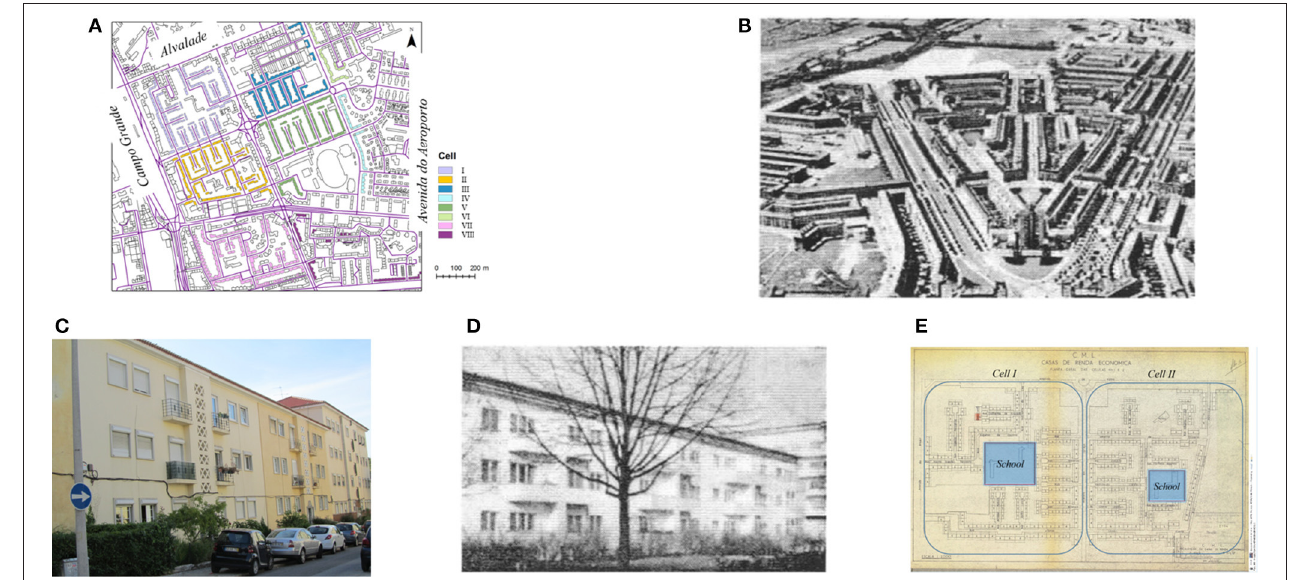
FIGURE 3 | Comparison between “Bairro de Alvalade” in Lisbon and other cities. Areas in (A) “Bairro de Alvalade” and (B) Amsterdam (Costa, 2005). Buildings in (C) “Bairro de Alvalade” and (D) Berlin (Costa, 2005). (E) Primary school as a central element (City Hall) 1